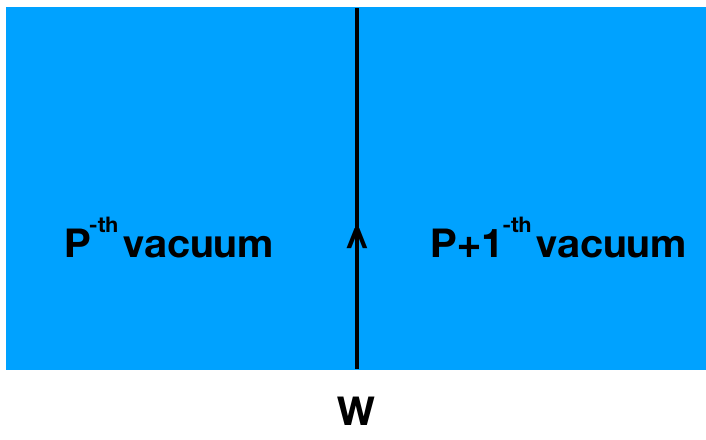
Figure 1 . Two DW vacua (4.2) separated by a fundamental quark worldline (Euclidean). As explained in section 3, W can be viewed as the end of a con(cid:12)ning string worldsheet extending into the R 3 bulk. The picture holds in the high- T DW on R 3 (cid:2) S 1 , associated with center symmetry (cid:12) breaking. It also applies in the zero- T R 3 (cid:2) S 1 , in the semiclassically calculable (cid:3) NL (cid:28) 1 regime, L where the DW is associated with chiral symmetry breaking. In both the small- (cid:12) and small- L case, the DW worldvolume is 2-D. In the small- L case, the N P -vacua are represented by